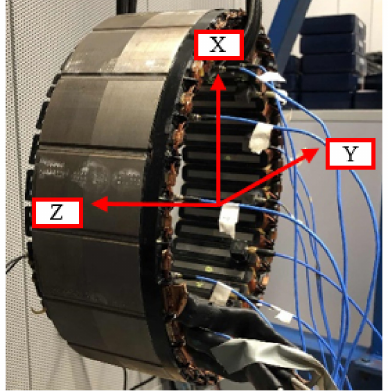
Figure 1. Motor stator and its reference